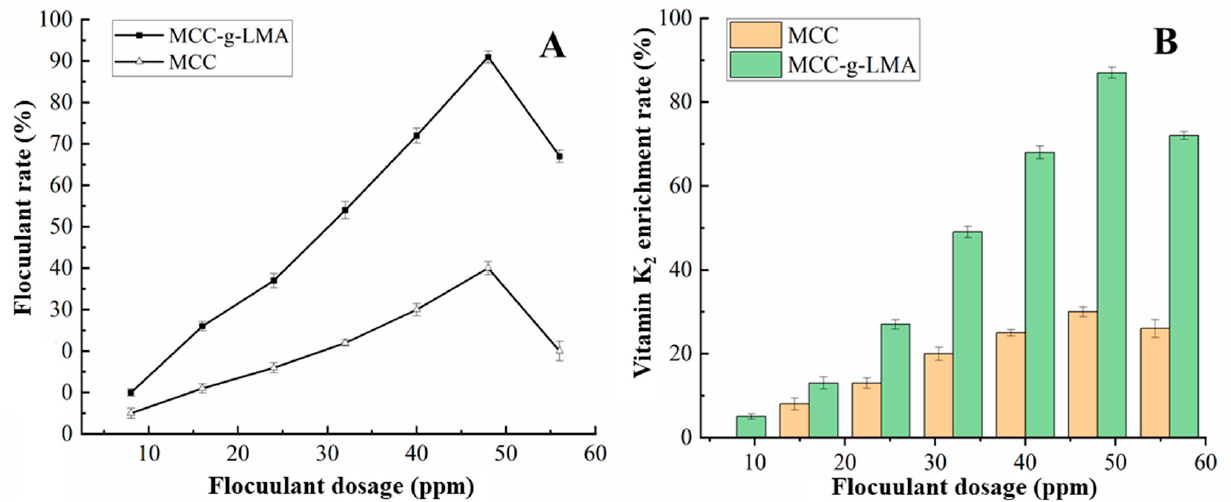
Figure 5. Effect of flocculant dosage on ( A ) flocculation rate and ( B ) the enrichment rate of vitamin K 2 .